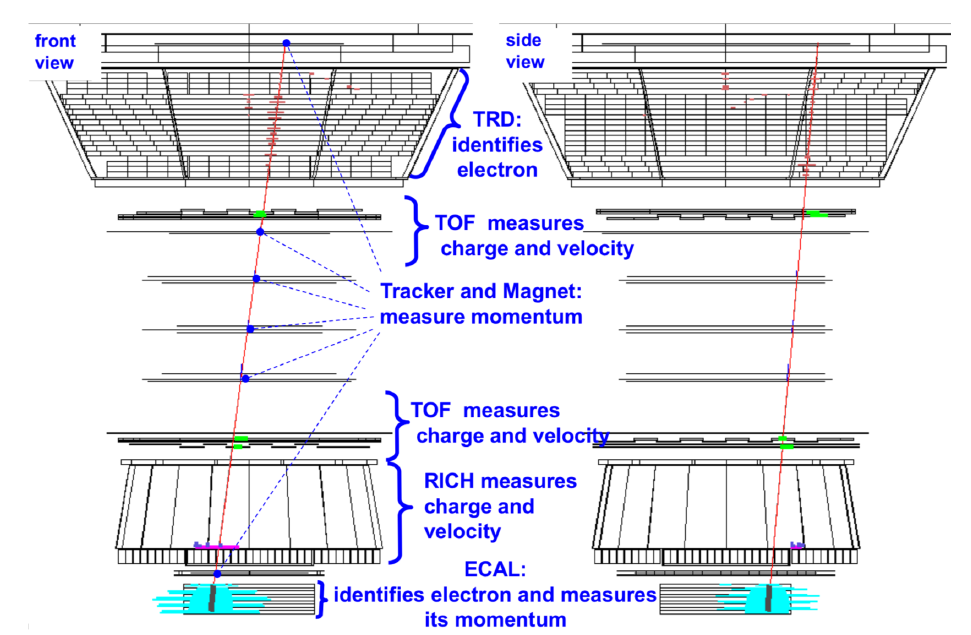
Figure 1. Example of reconstructed event.